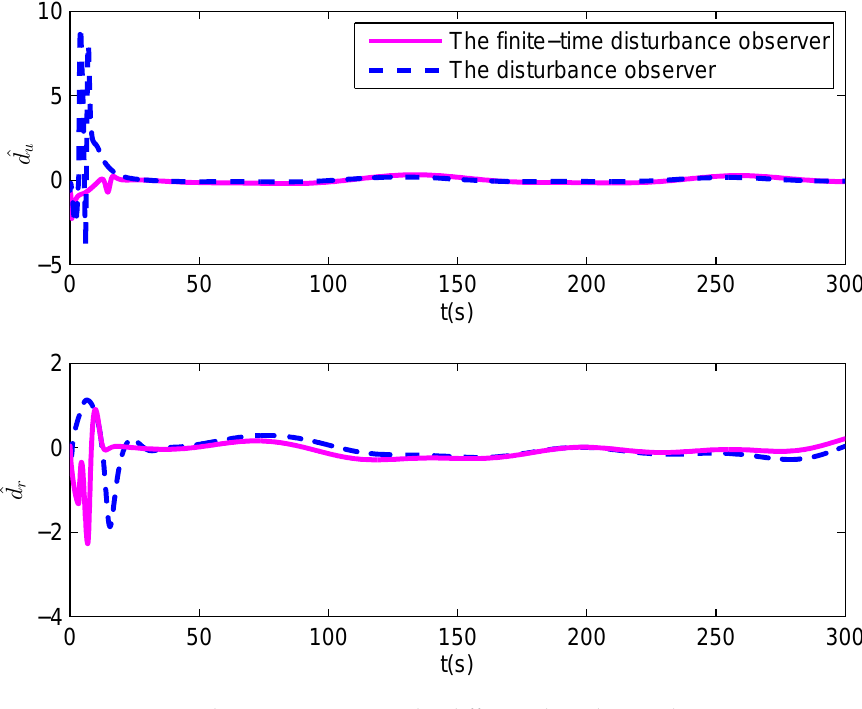
Figure 8. The estimation errors by different disturbance observers.